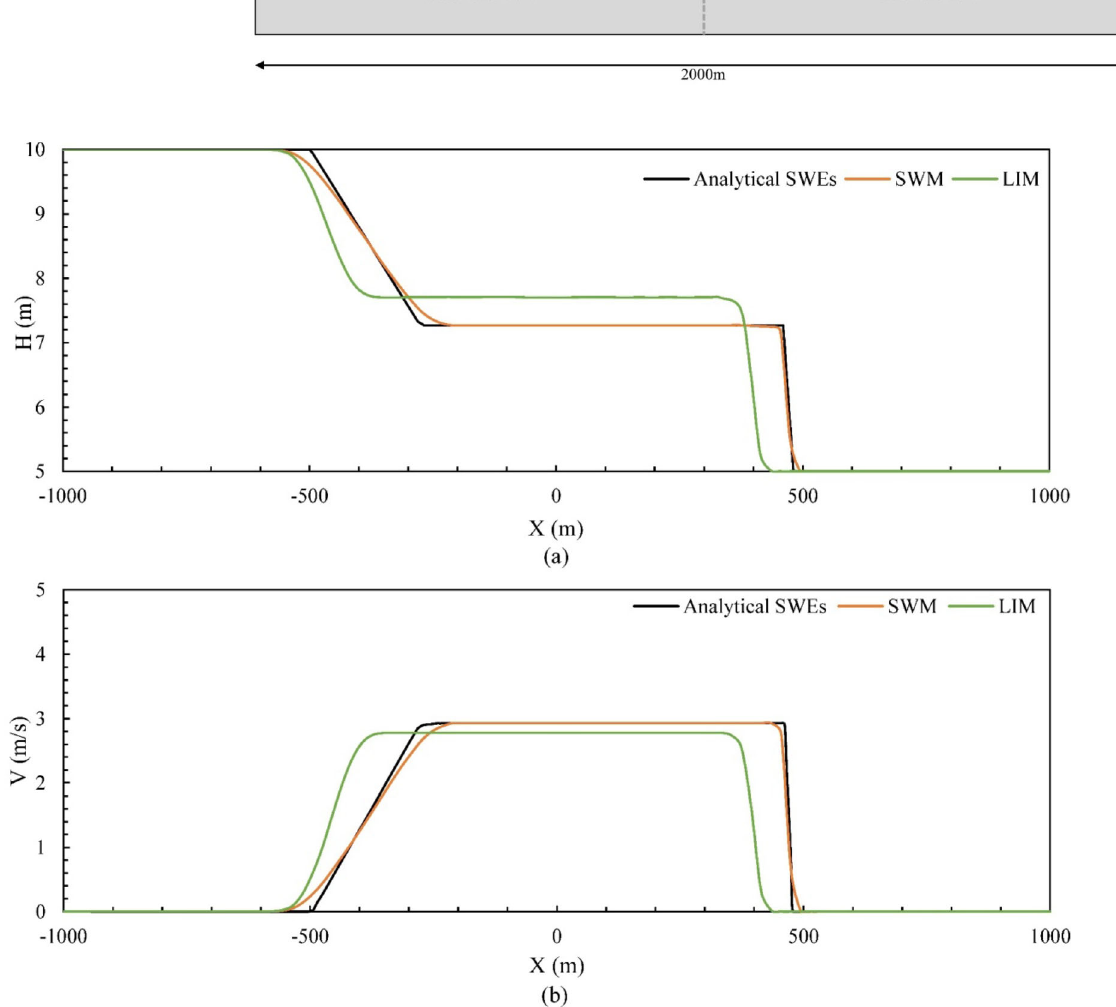
Fig. 2 Profiles of the water depth H ( a ) and flow velocity V ( b ). SWM = shallow water model, LIM = local inertial approximation form